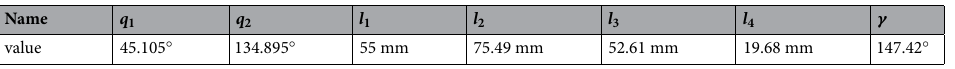
Table 1. Initial conditions of the existing model of the transformable wheel. The two input angles q 1 and q 2 have about 40 ◦ of workspace towards the center of their initial